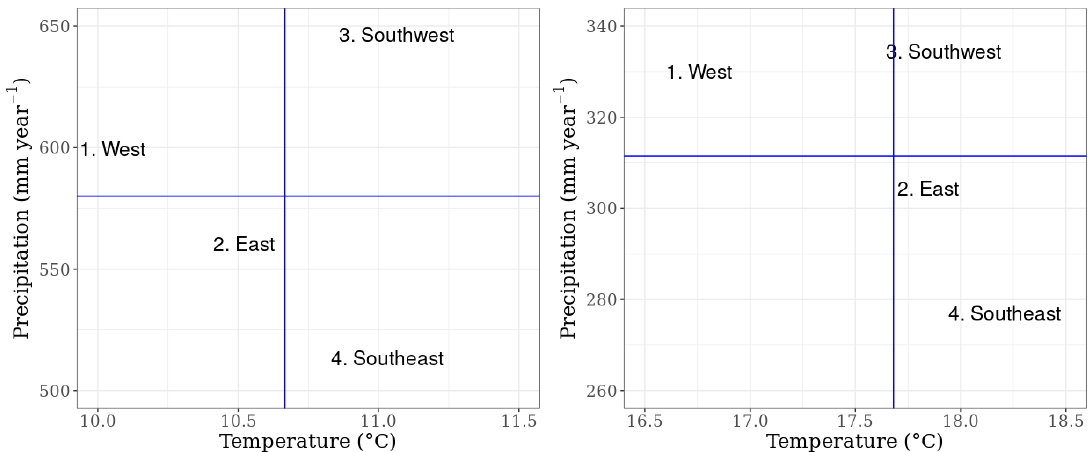
Figure 9. Biplots of the annual ( left ) and seasonal * ( right ) mean air temperature and average amount of precipitation in the four investigated regions (1970–2019). * Calculated for the vegetation period of maize (May–August).